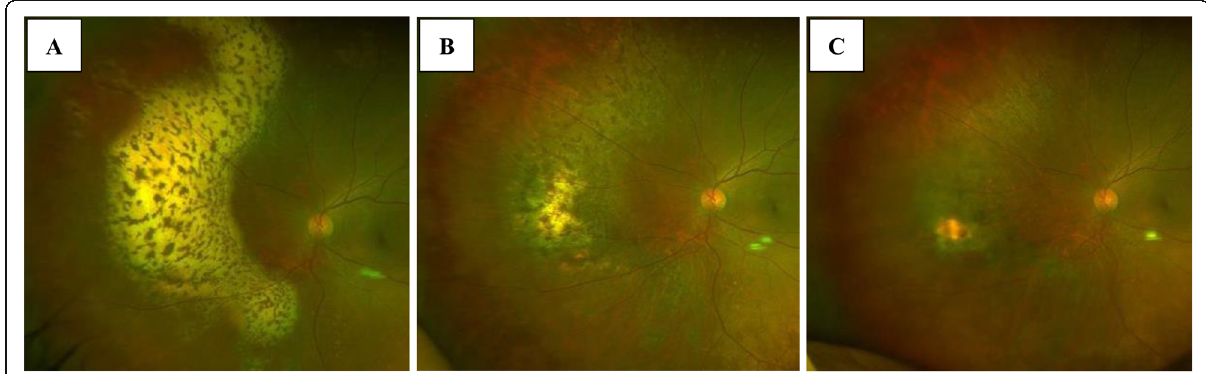
Fig. 3 Fundus findings after topical and systemic treatment. (A) After 3 intravitreal MTX injections, the peripheral lesions tended to shrink. (B) Four months after the start of chemotherapy, the major lesion remained partially regressed. (C) After initiation of CAR-T therapy, the lesion shrank